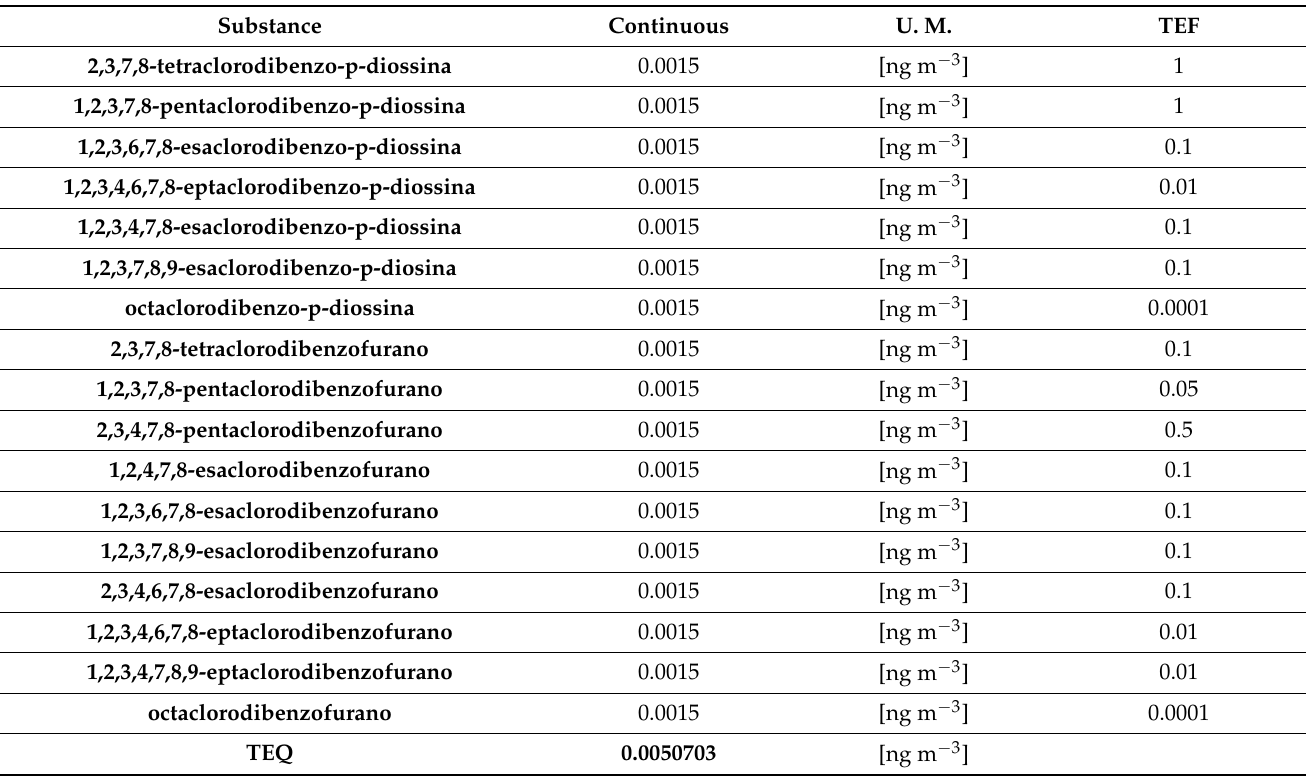
Table 11. Dioxin concentrations and